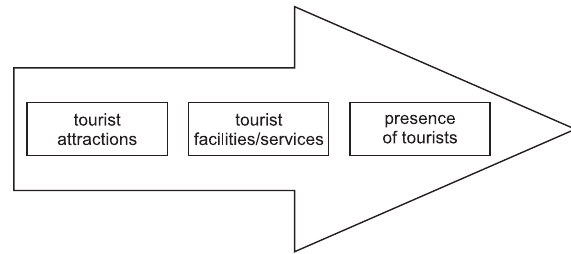
Fig. 1. The model of tourist landscape constituent element